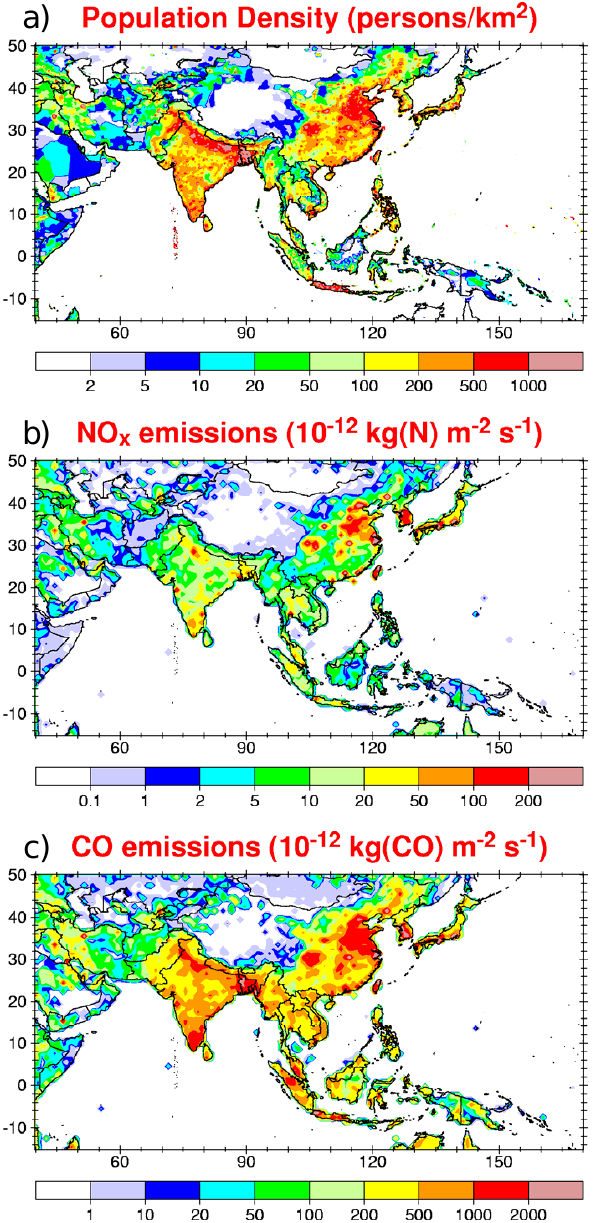
Fig. 2. Distributions of (a) population density (persons per square km), b) , emissions of NO x (10 − 12 kg(N)m − 2 s − 1 ), and (c) emis- sions of CO (10 − 12 kg(CO)m − 2 s − 1 ). (Population density is based on 0.25 ◦ gridded data for 2000 from the Center for International Earth Science Information Network (CIESIN) at Columbia Univer- sity, http://sedac.ciesin.columbia.edu/gpw/; Emissions data are the same as in Table 2, sum of all